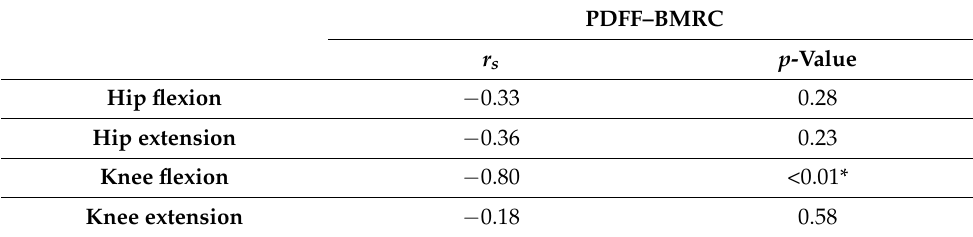
Table 7. Correlation of the proton density fat fraction (PDFF) with muscle strength. Table showing the results of correlation analyses between PDFF values and muscle strength as examined according to the British Medical Research Council (BMRC) scale. Spearman correlation coefficients ( r s ) and corresponding p -values are shown separately for muscle groups responsible for hip flexion and extension as well as knee flexion and extension. *: statistically significant after Bonferroni correction for multiple comparisons ( n =